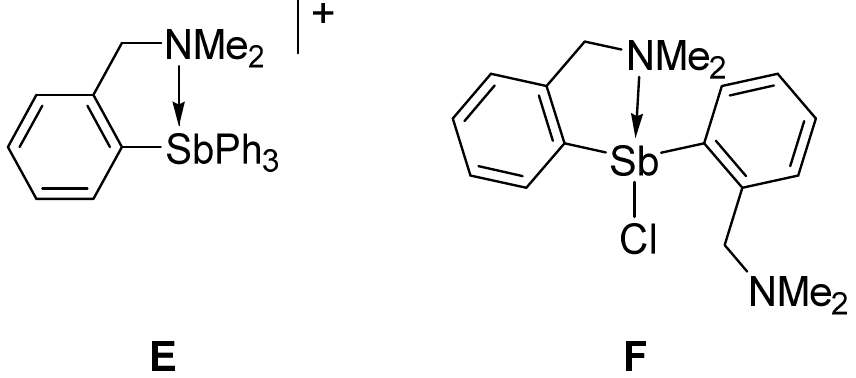
Figure 3. Selected examples of derivatives with N → Sb dative interactions. This distance is longer than that measured in E [30] or F [26], which possess N → Sb dative interactions of 2.693(11) Å and 2.463(2) Å, respectively (Figure 3). Based on this comparison, we conclude that an N → Sb dative interaction is also present in [ 3 ][Cl], even if weaker than in E and F . Efforts to reproduce the experimental geometry with DFT methods were not successful and led to computed structures where the Sb–N distance was overestimated by ~0.3 Å. We assign our difficulty in reproducing this distance to